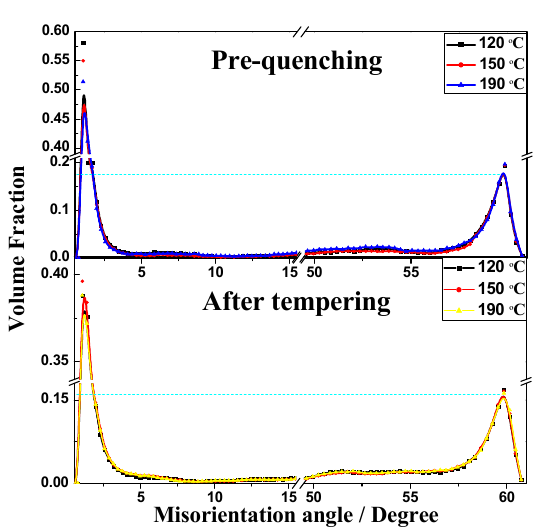
Figure 8. The misorientation angles before and after the tempering process.